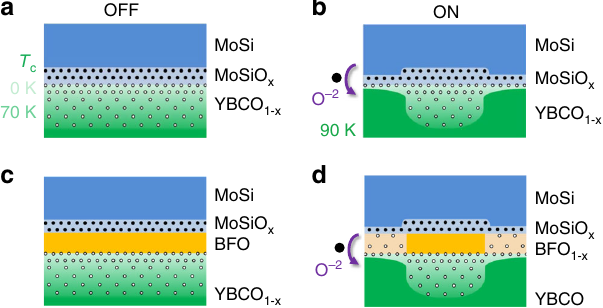
Fig. 6 Electro-resistance model based on electrochemistry. Schematic representation of the junctions with and without BFO. The oxygen anion ( O − 2 ; black dots) and oxygen vacancy ( V O + 2 ; hollow dots) distributions are indicated. a OFF state of the 0 nm BFO junctions. The bottom electrode shows a gradual oxygen depletion (and thus depressed superconducting properties) which is very strong near the interface due to the interfacial oxidation (MoSiO x ) of the top MoSi electrode. b By applying V pol > 0, O − 2 migrate downwards and the oxygen depletion is much more con fi ned near the interface, leaving optimally doped YBCO. This occurs on the junction ’ s ’ edges, where the electric fi eld is stronger. c OFF state of the junctions with BFO, in which YBCO shows gradual oxygen depletion (and thus depressed superconducting properties) which is very strong near the interface. In this state BFO is not signi fi cantly oxygen de fi cient . d By applying V pol > 0 (ON state), oxygen vacancies V O + 2 migrate into de BFO, resulting in a fully oxygenated YBCO and in oxygen-depleted, conducting